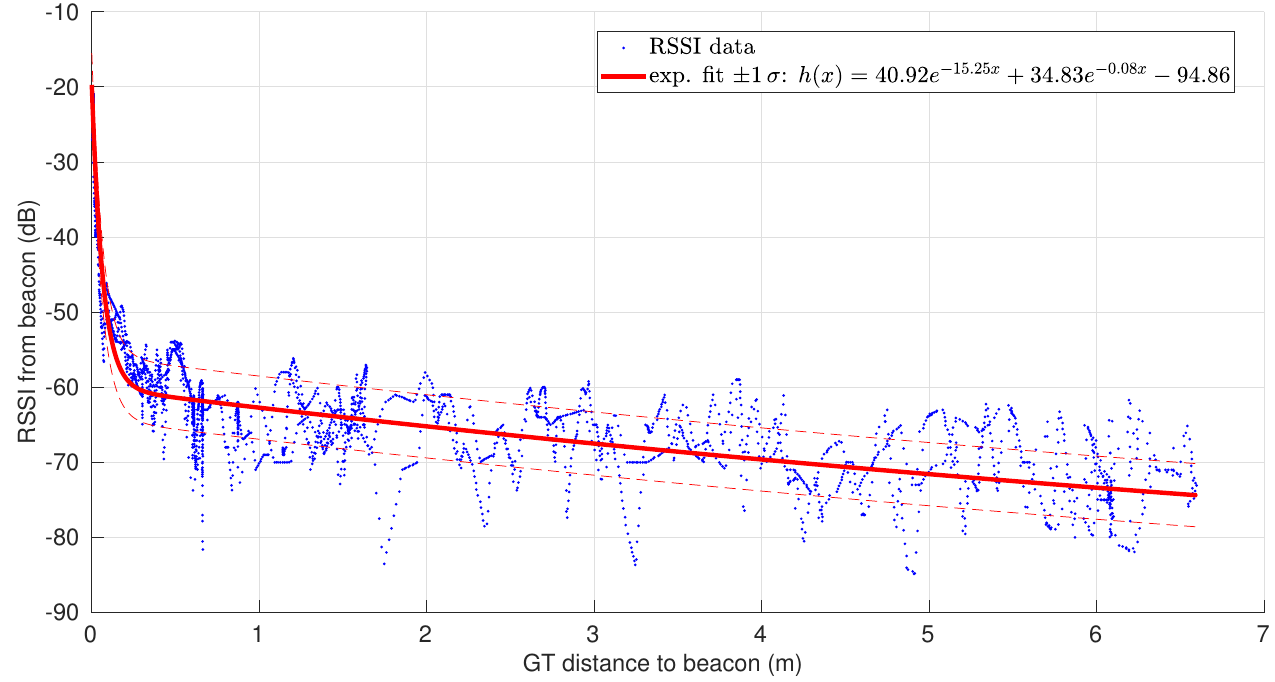
Figure 3. Readings of energy level from a BLE beacon vs. ground-truth distances (provided by LIDAR) in a scenario where we moved away from the beacon and then came back. An exponential sensor model is also shown [38].